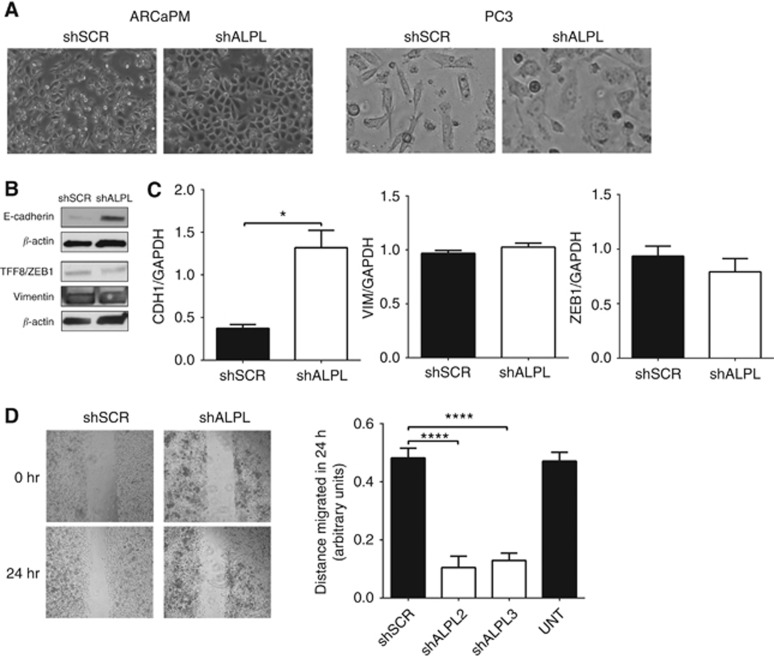
Inhibition of alkaline phosphatase activity induces MET and decreases migration. Prostate cancer cells transduced with scrambled shRNA (shSCR) or ALPL-knockdown shRNA (shALPL) were studied for features of EMT. (A) Cell morphology was documented by phase-contrast microscopy in ARCaPM cells and PC3 cells. (B) Protein levels and (C) mRNA expression of EMT markers were measured in ARCaPM cells using western blotting and qRT–PCR, respectively. (D) Cell migration was measured in ARCaPM using a scratch assay with light microscopy images taken at the indicated hours and quantitated using ImageJ. (*P<0.05, ****P<0.0001).